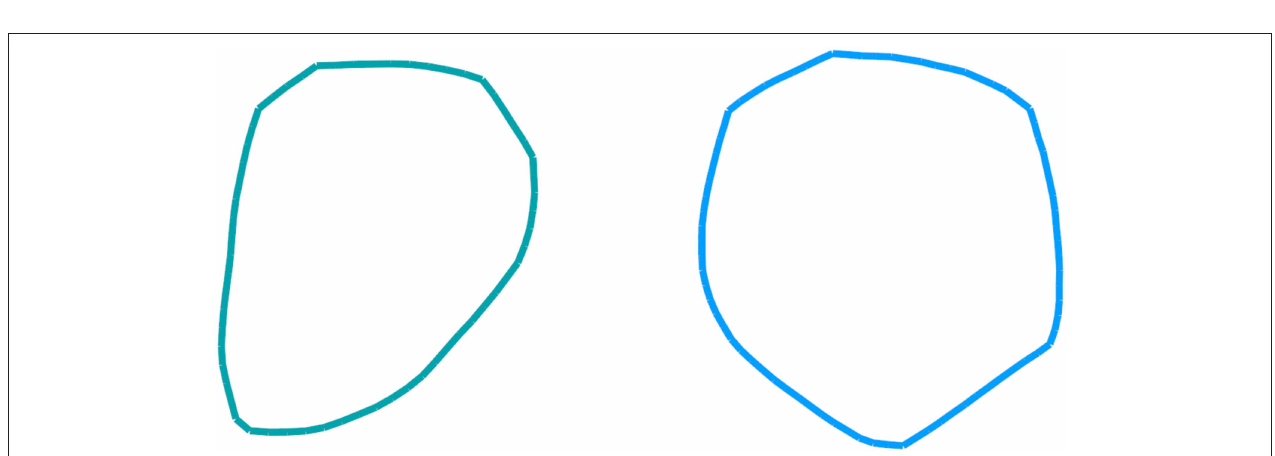
FIGURE 3 | Examples of a 60- base-pair (left) and 80- base-pair (right) loop conformations at 300 K corresponding to the non-convex bending potential of Figure 4 . The conformational ensembles were generated via coarse-grained simulations of DNA closed loops.